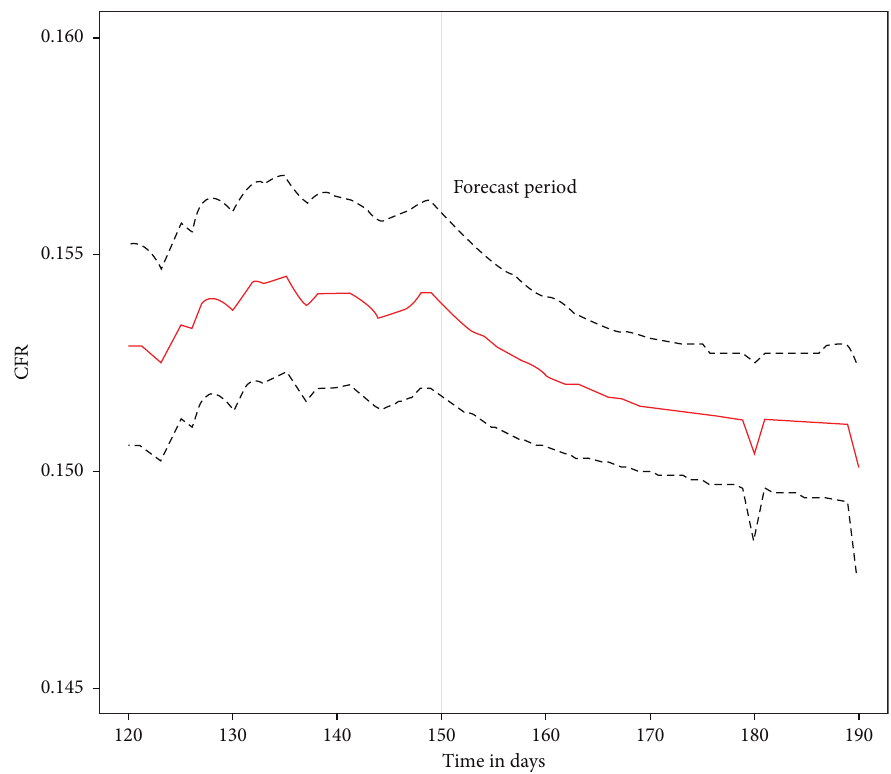
Figure 5: Modelled and forecast